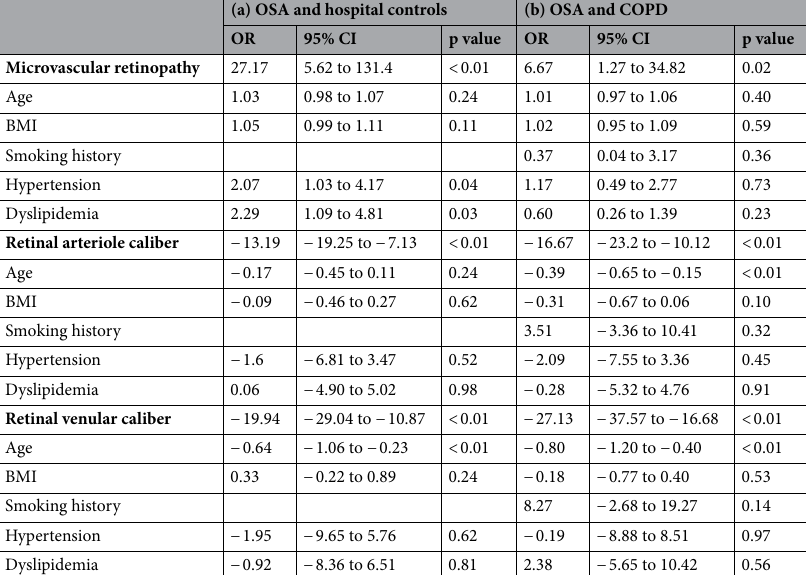
Table 5. Determinants of microvascular retinopathy, and vessel caliber in subjects with OSA, hospital controls or with COPD in a multivariate analysis. This study included a.individuals with OSA or hospital controls or b. individuals with OSA or COPD; and examined for microvascular retinopathy, retinal arteriole calibre or retinal venular calibre taking into account the same variables for each that were demonstrated in Tables 3 and 4 (age, BMI, smoking history, hypertension diagnosis and